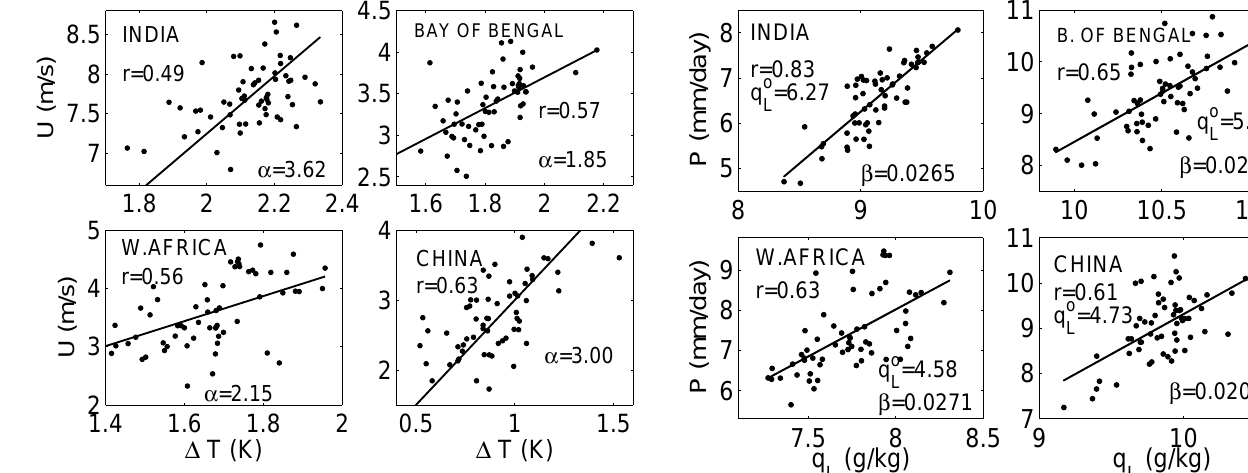
Fig. 4. Precipitation P versus specific humidity over land, q L , from NCEP/NCAR reanalysis data. The black line shows the result of a linear regression, the correlation coefficient r is indicated, as well as the slope β (in kgm − 2 s − 1 ) and the offset in terrestrial humidity, q o (in gkg − 1 L